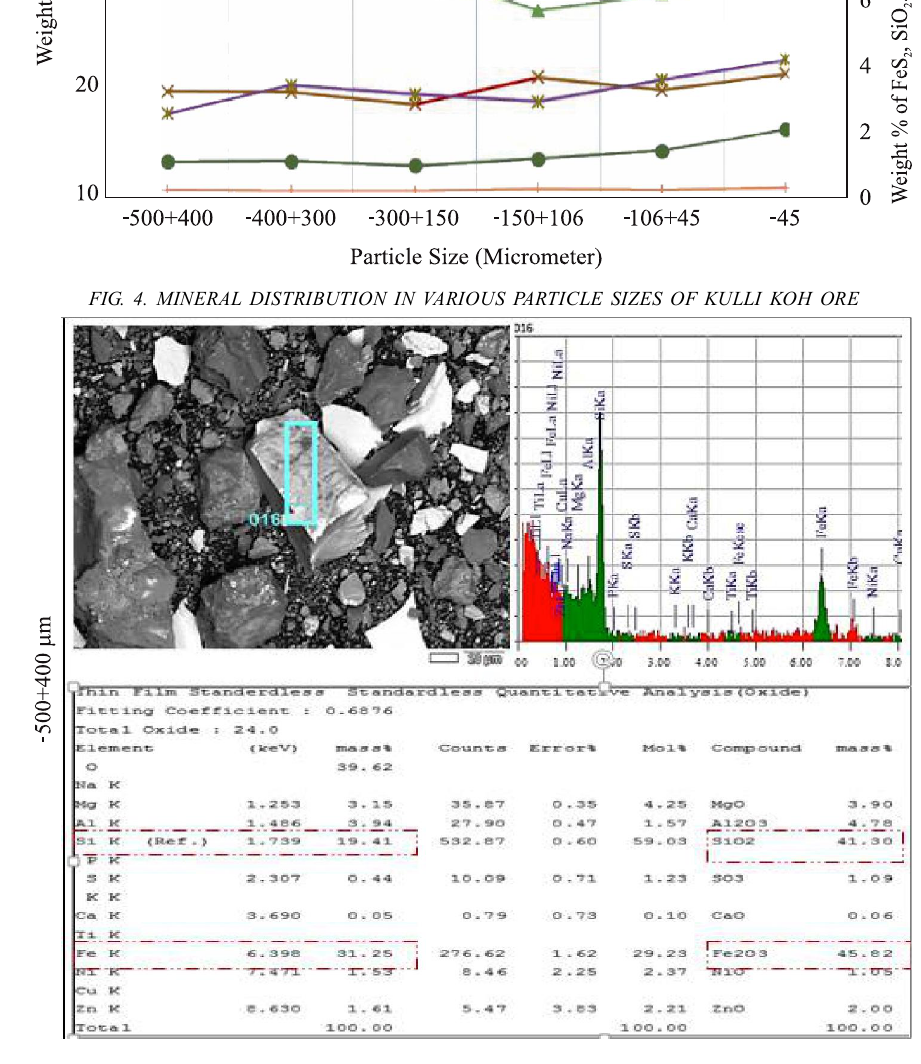
FIG. 5(a). SEM-EDS SPECTRA AND GRADE OF -500+400 